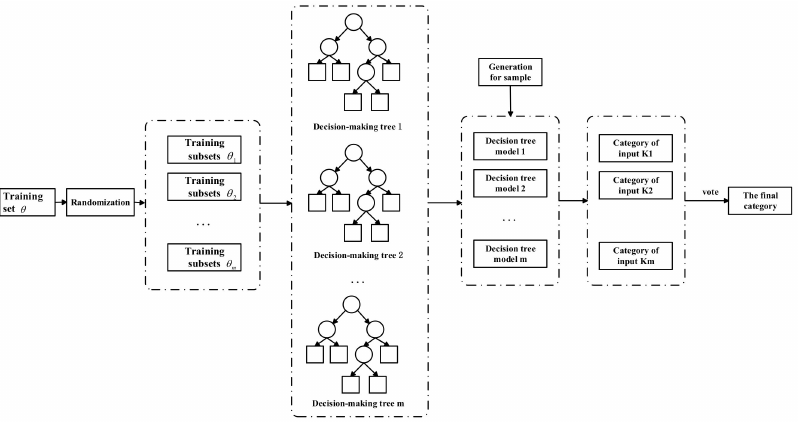
Figure 2. Random forest model framework